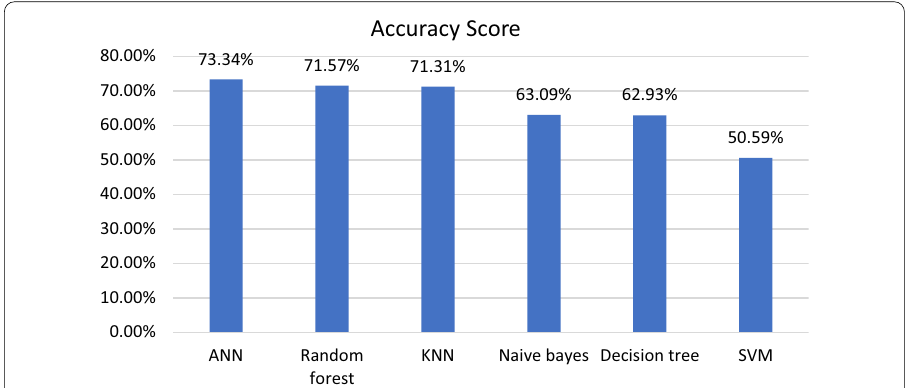
Fig. 7 Accuracy of different machine learning